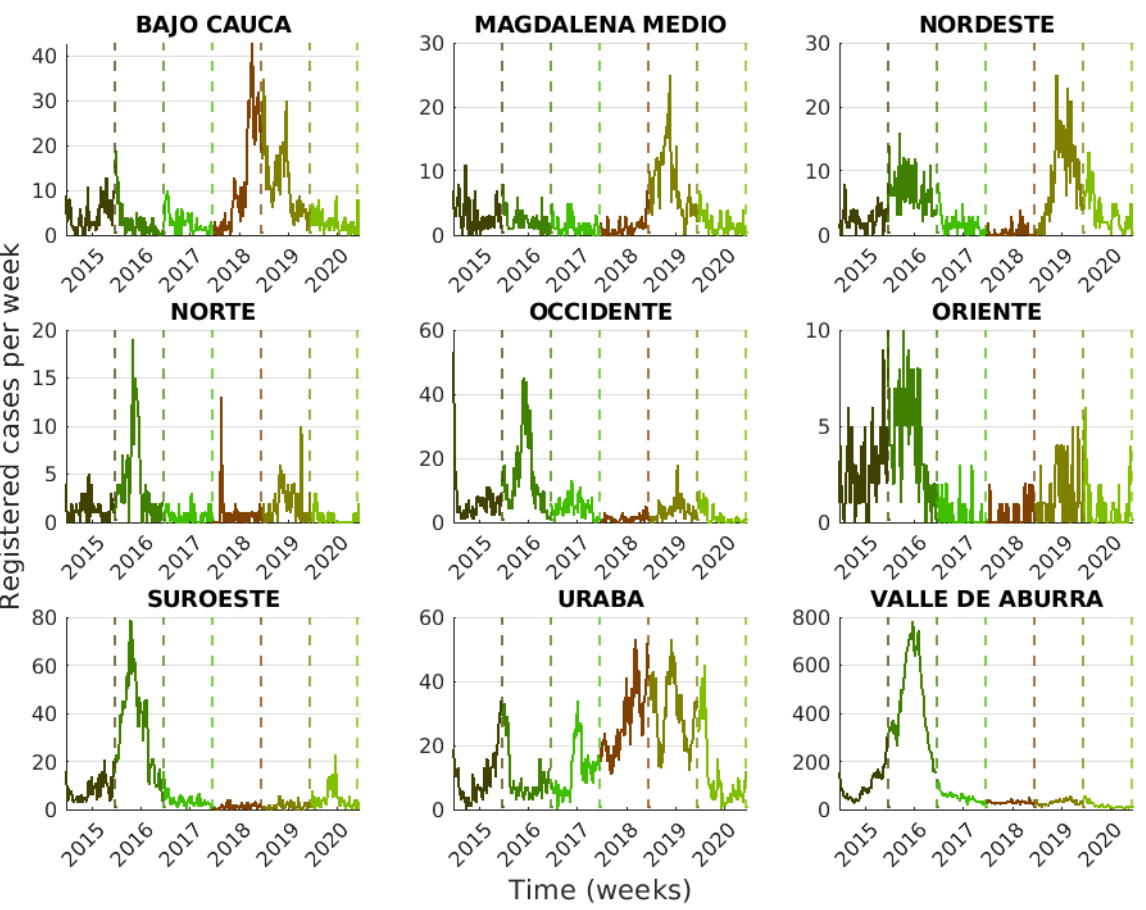
Figure 3. Time-series of reported dengue cases per subregion during 2015–2020. Different colors in the graphs represent the